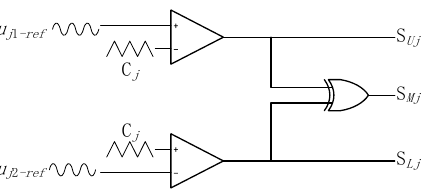
Figure 4. Control method for the hybrid nine-arm high-voltage inverter